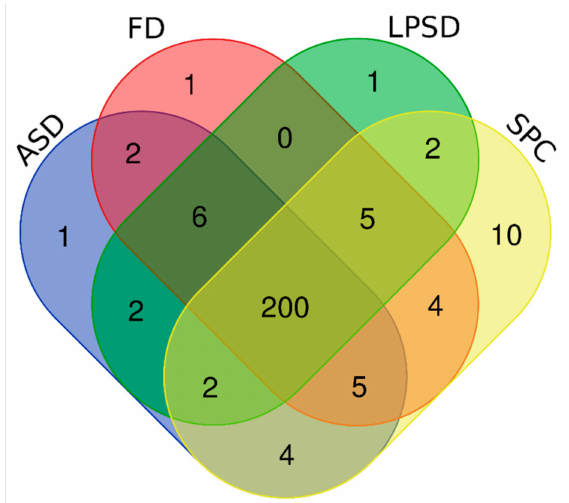
Figure 5. Venn diagram of the identified serum proteins from SPC, ASD, LPSD and FD. Proteins with significant changes between the four groups are illustrated by volcano plots, as shown in Figure 6. The significance level was selected based on a fold change > 2 or <2 and p < 0.05. Based on these levels, there were 4, 8 and 10 proteins that were sig- nificantly changed after ASD, LPSD and FD, respectively. Among them, three proteins, namely 45-kDa calcium-binding protein, fibrinogen gamma-B chain and TKT protein, in- creased in the three drying methods (Table S1). Liu, Zhang [11] also reported the increased abundance of 45-kDa calcium-binding protein after heating and ASD, which is consistent with the data obtained here. It was reported that 45-kDa calcium-binding protein was a complex containing 8-kDa calcium-binding protein dependent on calcium and disulfide bond formation [14]. Therefore, the increased abundance of this protein may have resulted from drying. TKT was reported to have several functions, such as calcium and magne- sium ion binding, protein homodimerization and thiamine pyrophosphate binding. The content of TKT was significantly higher in mature milk than in transitional milk [15]. The other increased protein in ASD powder was the renin receptor, whose content was also increased after FD. This protein plays a vital role in the renin–angiotensin system, which is associated with hypertension and diabetes [16]. For LPSD, the eight significantly changed proteins were also changed in FD samples, and the other five proteins were either decreased (apolipoprotein C-III) or increased (endoplasmic reticulum chaperone BiP, cathelicidin 1, protein OS-9 and haptoglobin). Apolipoprotein C-III binds to the high-density lipoprotein particle receptor, while phospholipid functions as a lipase inhibitor, which is very impor- tant for the homeostasis of triglyceride levels [17]. The endoplasmic reticulum chaperone BiP is essential for the cytoplasmic assembly compartment, and its depletion results in the loss of lamin phosphorylation [18]. Cathelicidins possess antimicrobial activity and promote inflammation, and their abundance is increased in mastitic cow milk [19,20]. The only protein that changed in FD powder, and not in the other two types of powder, was nucleoside diphosphate kinase B. This protein functions as a regulator of endocytosis and tracheal development